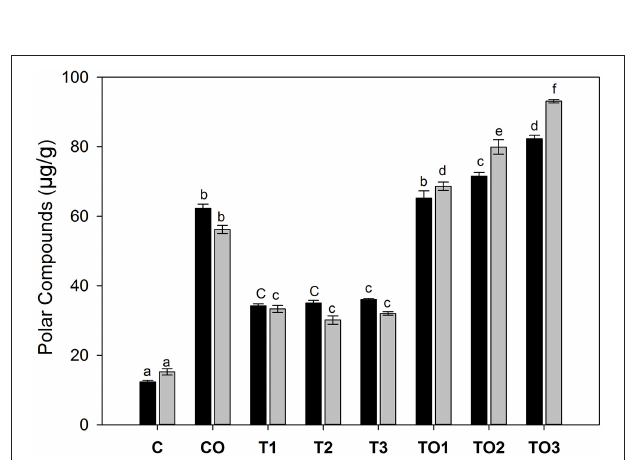
FIGURE 2 | Representative liver sections of male rats (A) TO1, (B) TO2, (C) TO3, (D) T1, (E) T2, (F) T3, (G) control and (H) oxidized olive oil group. CV is central vein and F is fats accumulated.